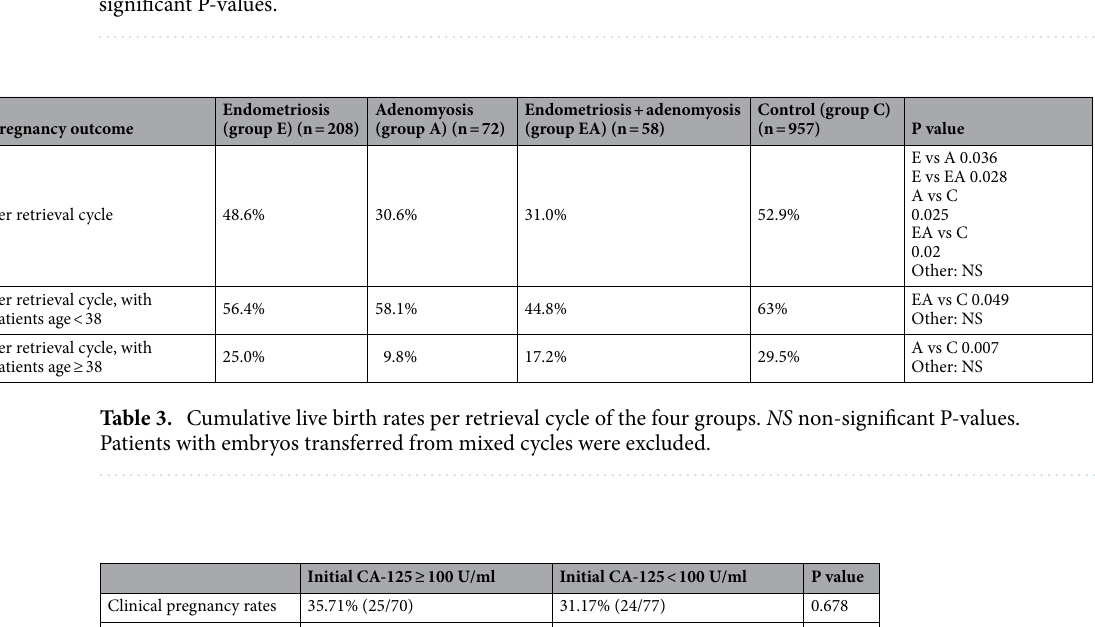
Table 2. Pregnancy outcomes of 1st frozen-thawed embryo transfer cycles (FET) of the four groups. NS non- significant P-values.